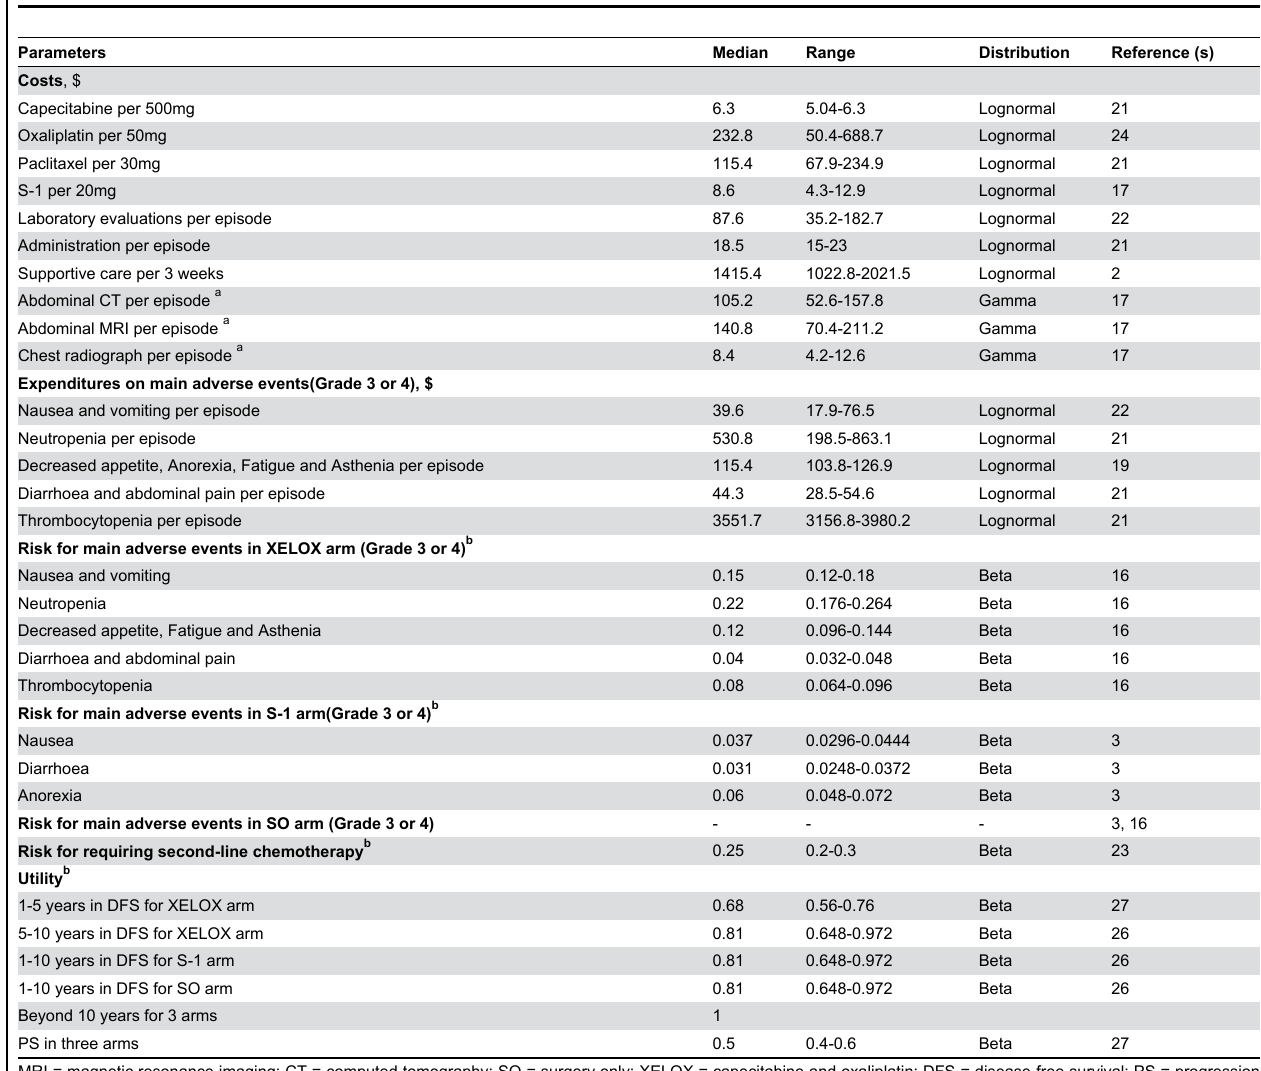
Table 4. Baseline costs, utility values and risks in three groups for patients with stage Ⅱ - Ⅲ B gastric cancer in China.